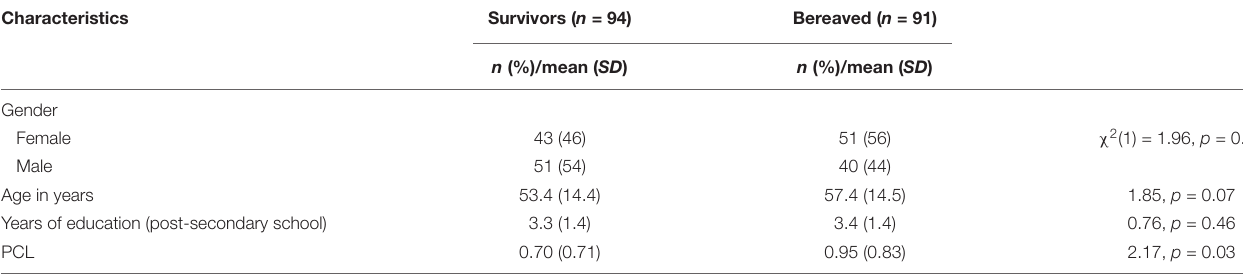
TABLE 1 | Mean participant characteristics with standard deviation in parentheses.